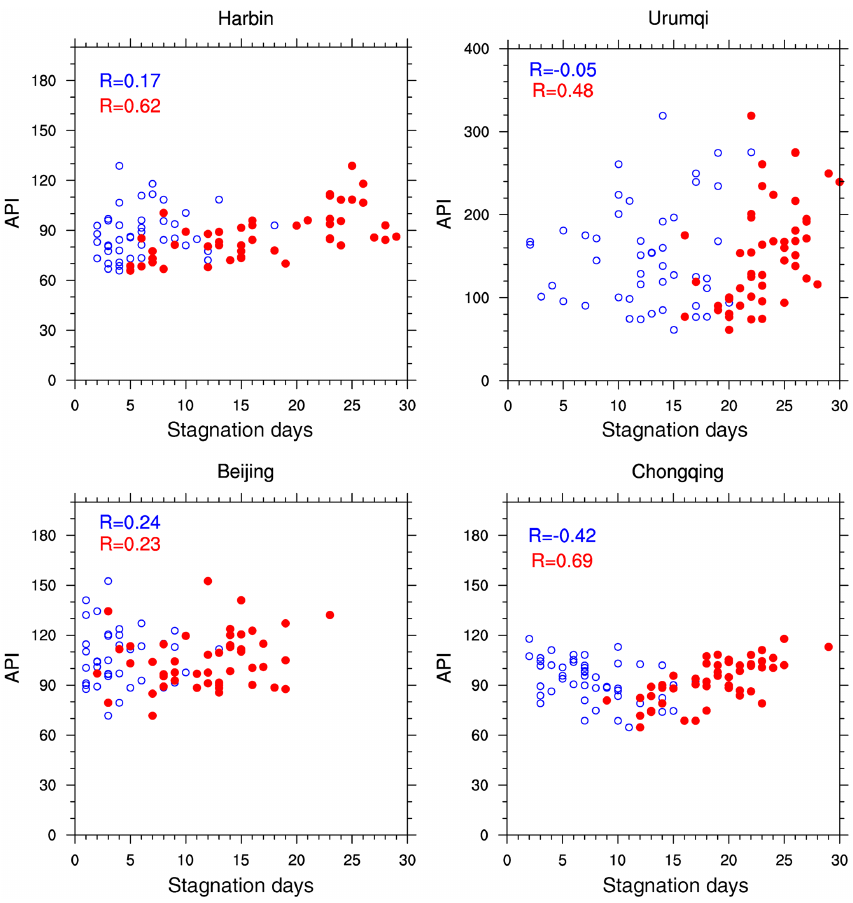
Figure 12. Correlations between monthly mean API and the total air stagnation days in the corresponding month in China winter half- year (October–March) during 2000–2012. R stands for correlation coefficient. Blue: ASI; red: BSI.